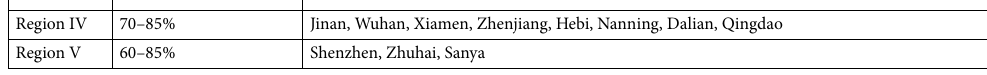
Table 1. Volume capture ratio of annual rainfall in SCP pilot cities 9,34